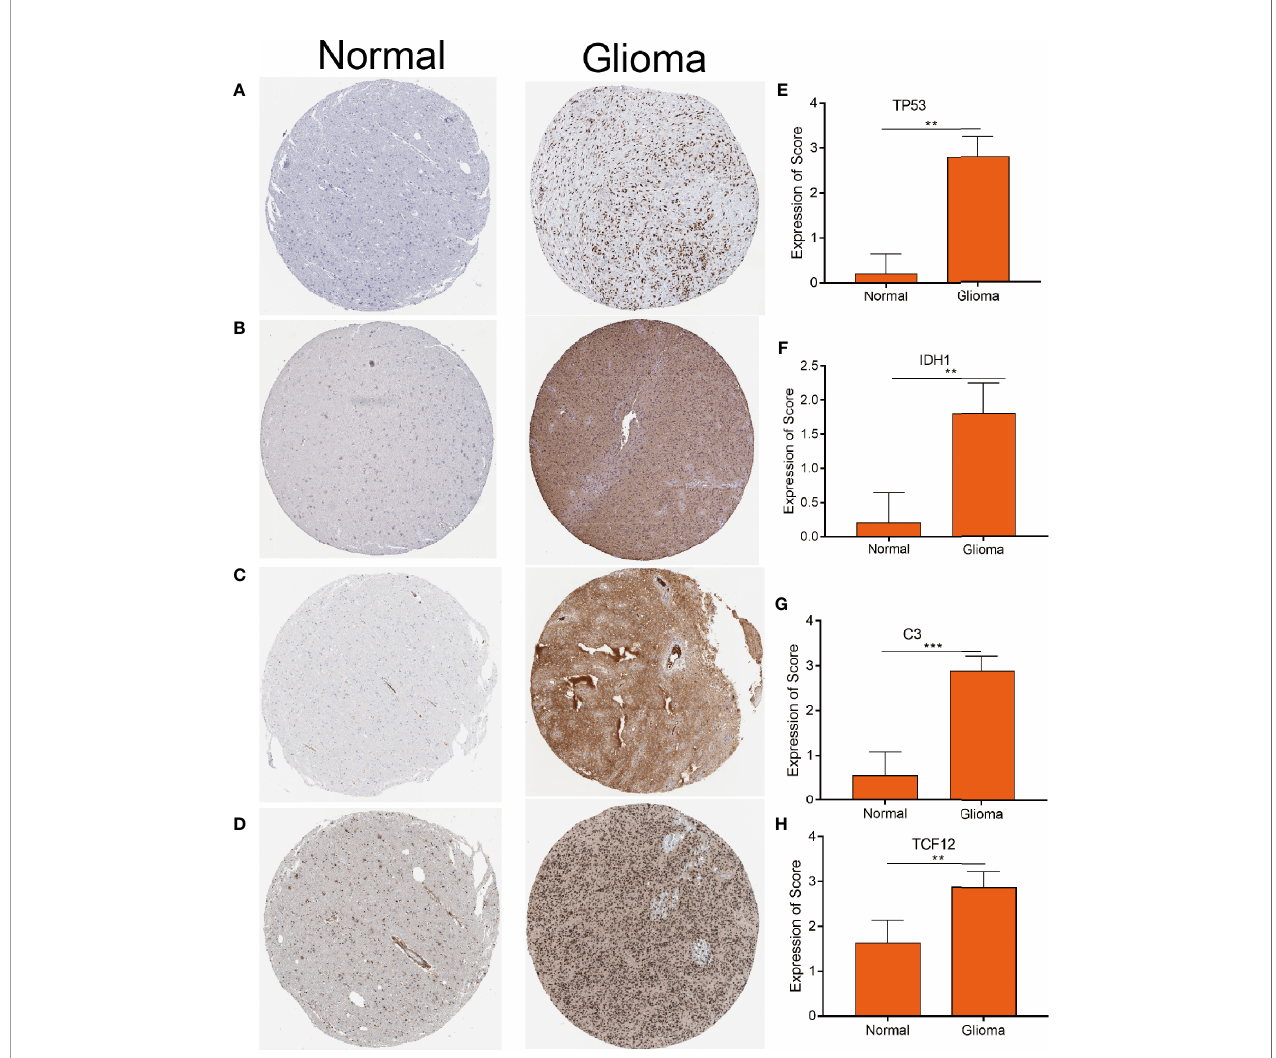
FIGURE 3 | Distinctively expressed proteins in human glioma tissue and normal brain tissue. (A – D) The protein expression of TP53 (A) IDH1 (B) C3 (C) and TCF12 (D) . Representative photos are shown (100×), Scale bar = 100 m m. (E – H) The protein expression scores of glioma tissue and normal brain tissue are shown. ***p < 0.001 by t-test indicated a signi fi cant difference from normal tissues. **p <